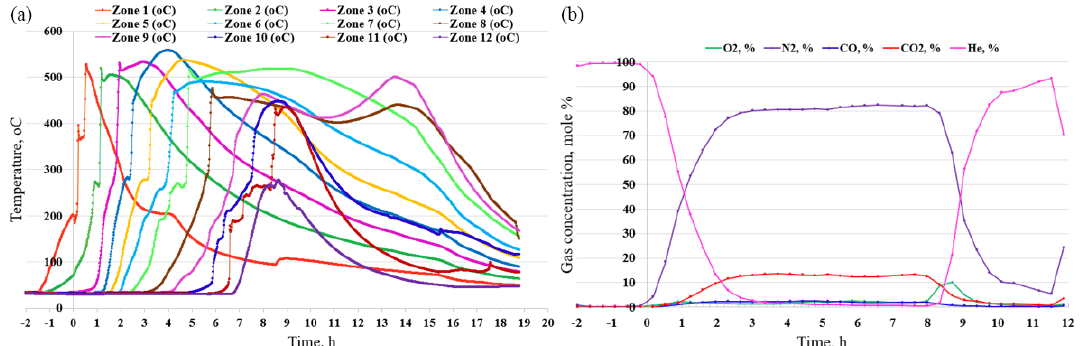
Figure 2. Temperature profiles on the centreline (a) ; Combustion gas mole concentrations (b)